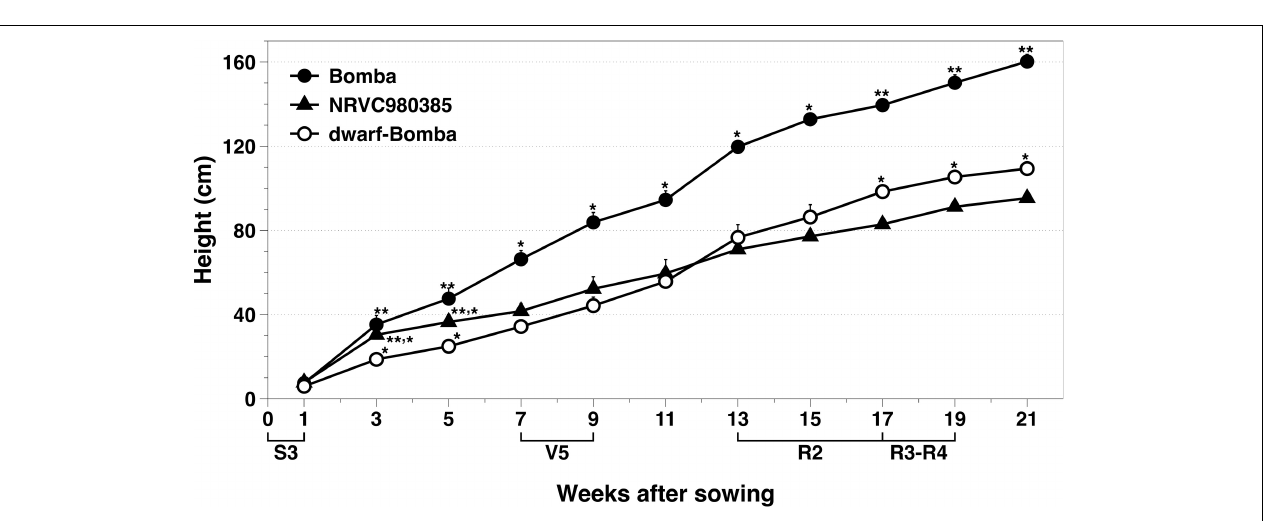
were analyzed, as this concentration is near the LOD values for those